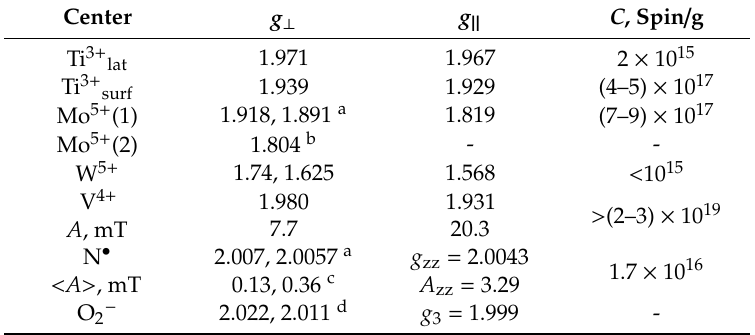
Figure 6. EPR spectra at 30 K of TiO 2 / MoO 3 photocatalyst before ( a ) and after 10 min ( b ) of UV light illumination. Table 1. Spin-Hamiltonian parameters calculated from EPR spectra for paramagnetic centers